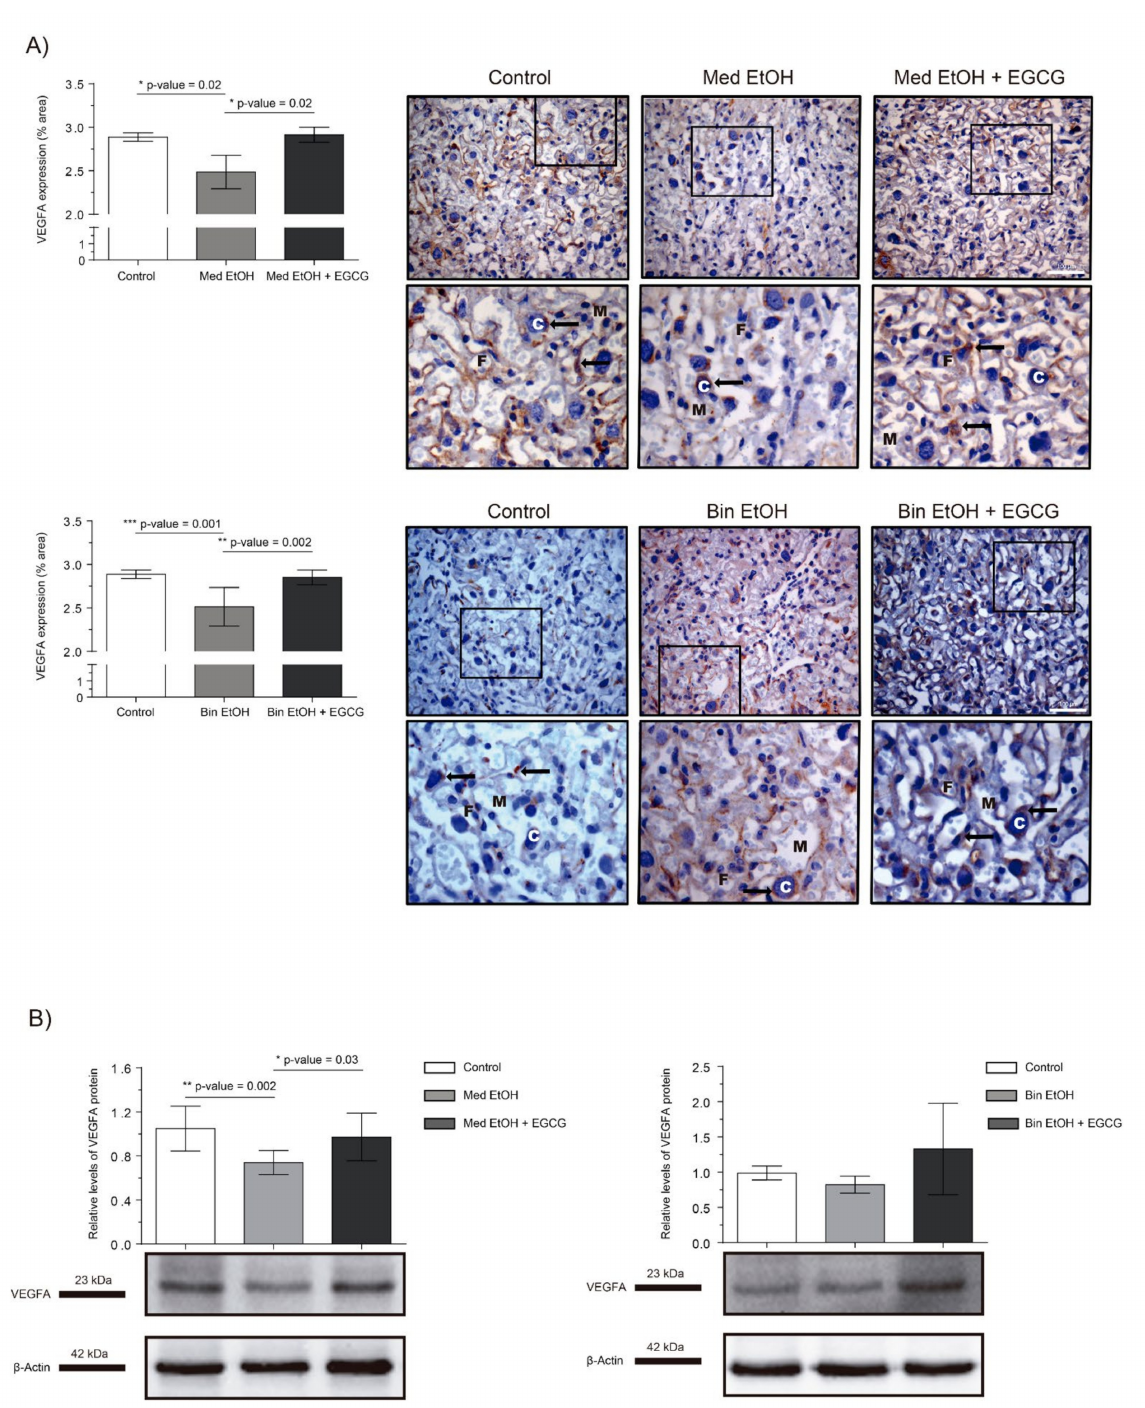
Figure 2. Representative vascular endothelial growth factor A (VEGF-A) immunostaining of placenta sections ( A ) and Western blot VEGF-A protein analysis in placental lysed samples ( B ) for prenatal alcohol exposure (PAE) and EGCG treatment for binge and Mediterranean patterns. ( A ) Boxed VEGF-A immunostaining sections represent the enlarged image of the labyrinth zone. VEGF-A quantification at two different fields (40 × ) per section. ( B ) Representative Western blot of VEGF-A expression observed in all analyzed samples under the various experimental conditions. Protein levels were normalized using α -tubulin as load control. Arbitrary units express “fold change”. At least five samples from different litters were used from each group. For intergroup comparisons, the Kruskal–Wallis test (Dunn’s test for multiple comparisons) was used. Asterisks denote the level of significance: * p -value < 0.05, ** p -value < 0.01, *** p -value < 0.005. M: maternal blood; F: fetal blood; C: cytotrophoblast; arrows: VEGF-A positive